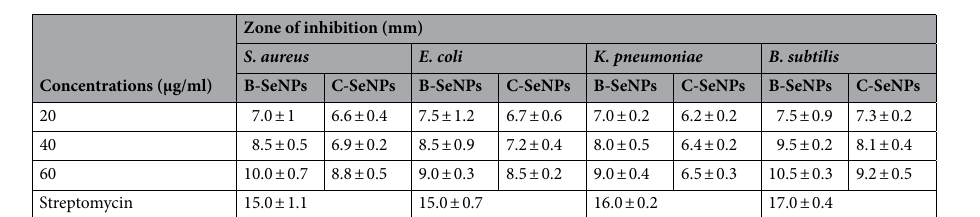
Table 4. Anti-bacterial activity of B-SeNPs and C-SeNPs by disc diffusion method.